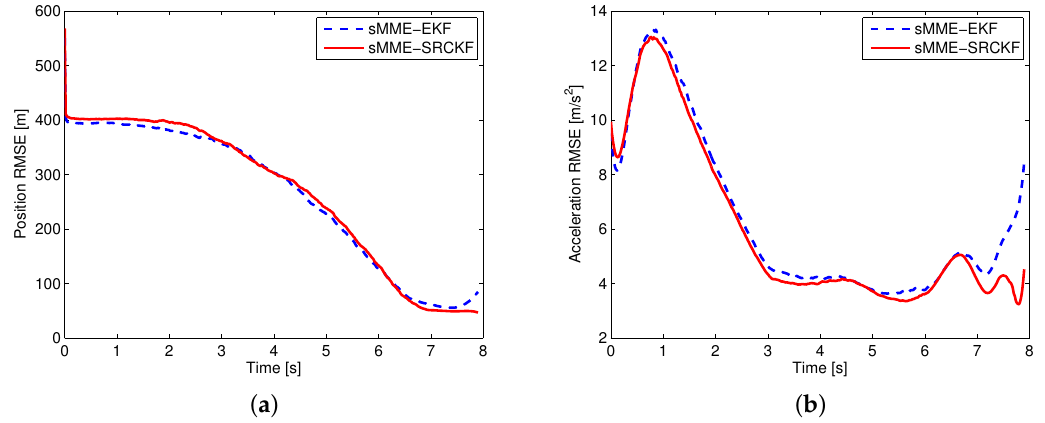
Figure 10. Estimation errors of the sMME-EKF and sMME-SRCKF: ( a ) position RMSE, ( b ) acceleration